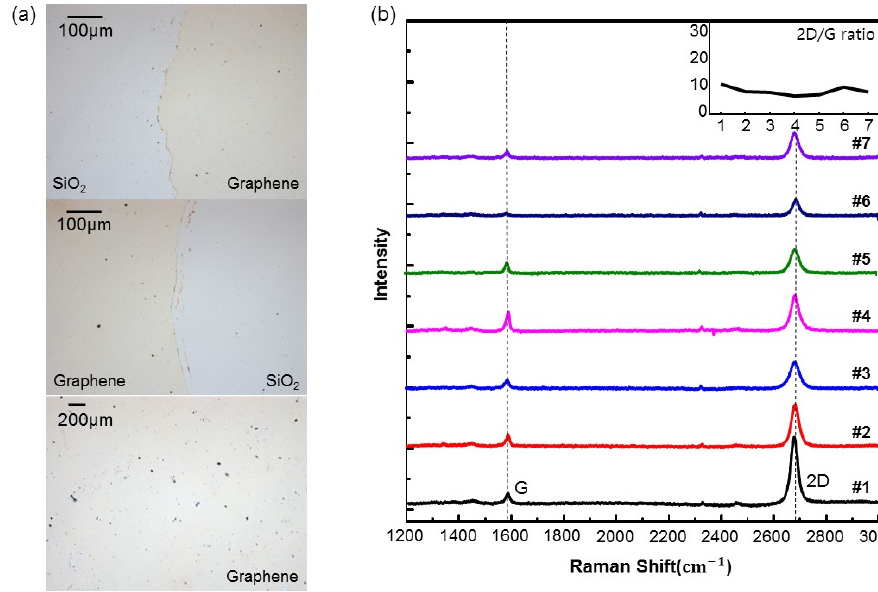
Figure 2. ( a ) OM images of graphene on Si/ SiO 2 transferred with bubble transfer method. ( b ) Raman spectrum of graphene made by a Cu foil used for seven cycles of graphene growth and transferred with bubble transfer method.